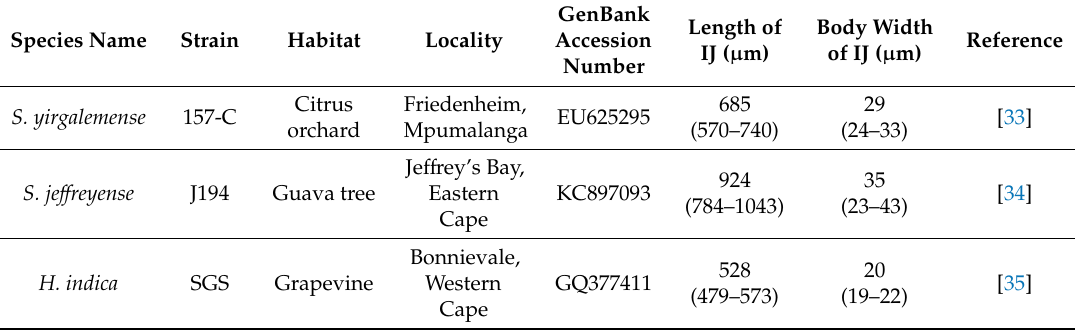
Table 2. List and characteristics of the Steinernema and Heterorhabditis species